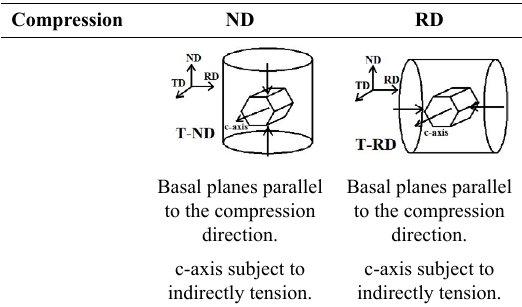
Table 3. The relative orientation between basal planes and c-axis with the loading